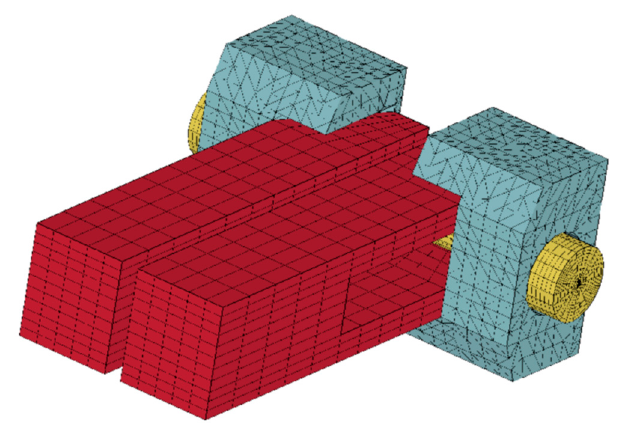
Figure 8. A view of finite element model of the Flying Wedge.